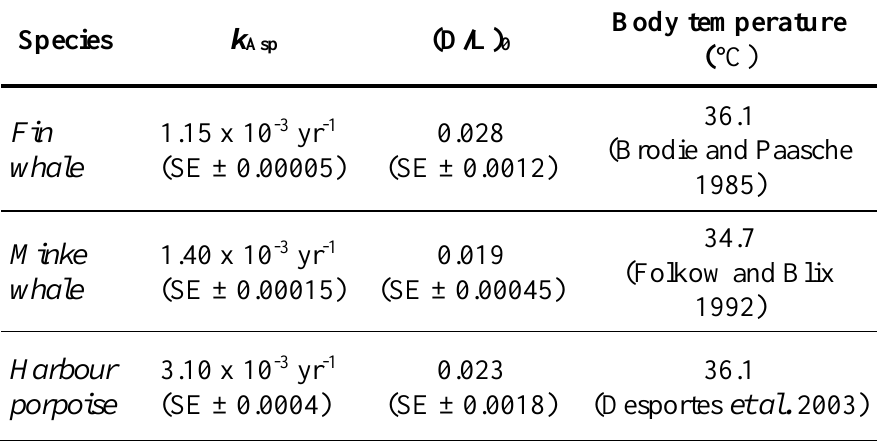
Table 1. k , D/L and body temperature for the three species of Asp 0 cetaceans presented in this